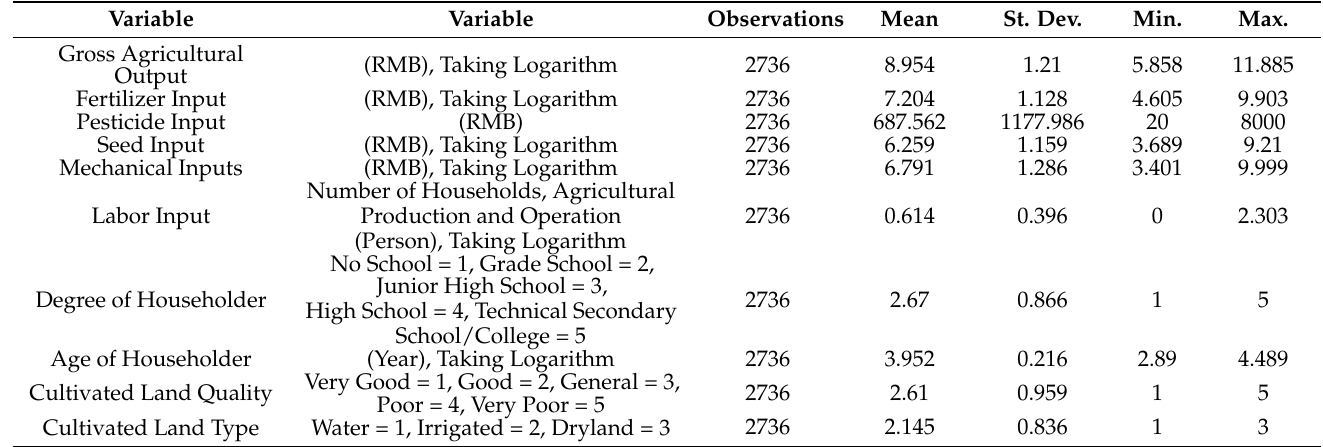
Table 2. Variable Classification and Descriptive Statistics of Production Function Model.